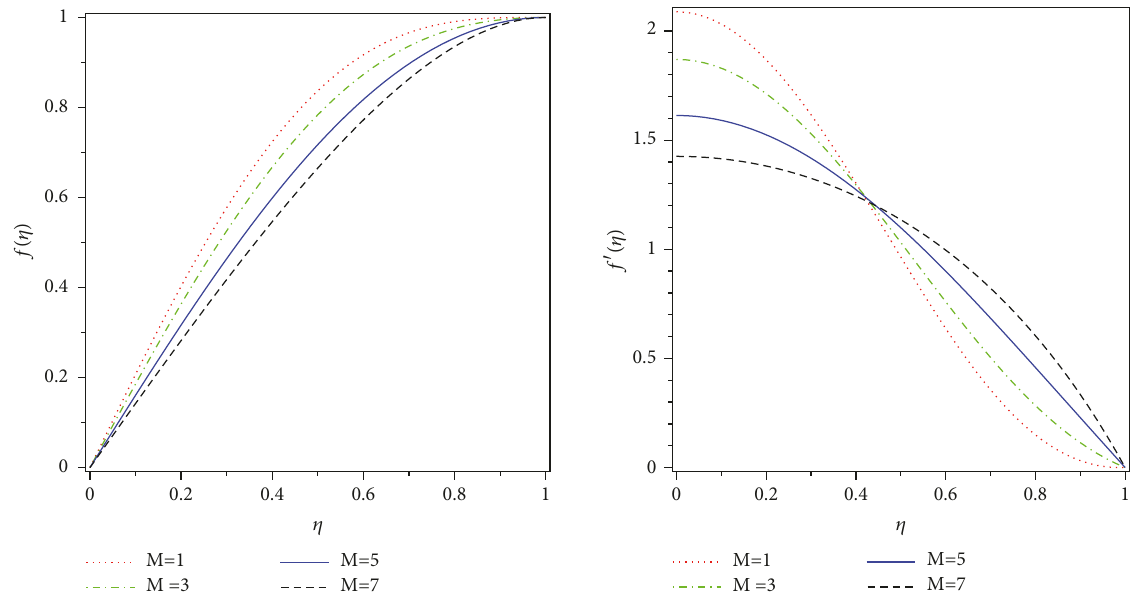
Figure 6: 𝑓(𝜂) and 𝑓 󸀠 (𝜂) for the values 𝑀 when 𝑆 = −10 , 𝛾 = 0.4 .